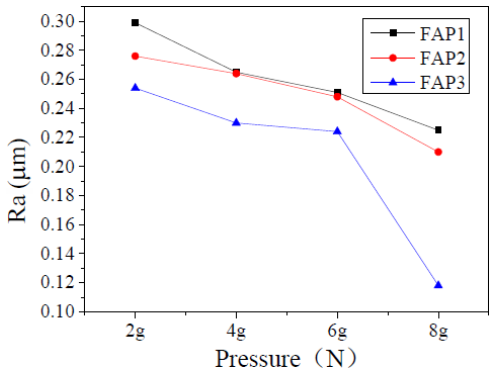
Figure 13. Surface roughness vs. pressure.